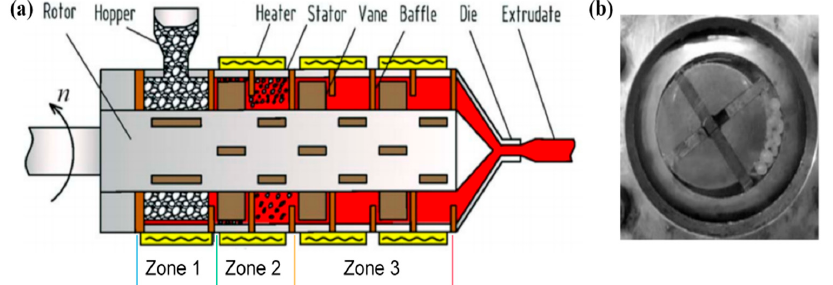
Figure 3. ( a ) Structure of a vane extruder (VE) with different working sections. ( b ) Photograph of the solid compaction zone. Reproduced with permission from [21]. Copyright 2014, John Wiley and Sons.